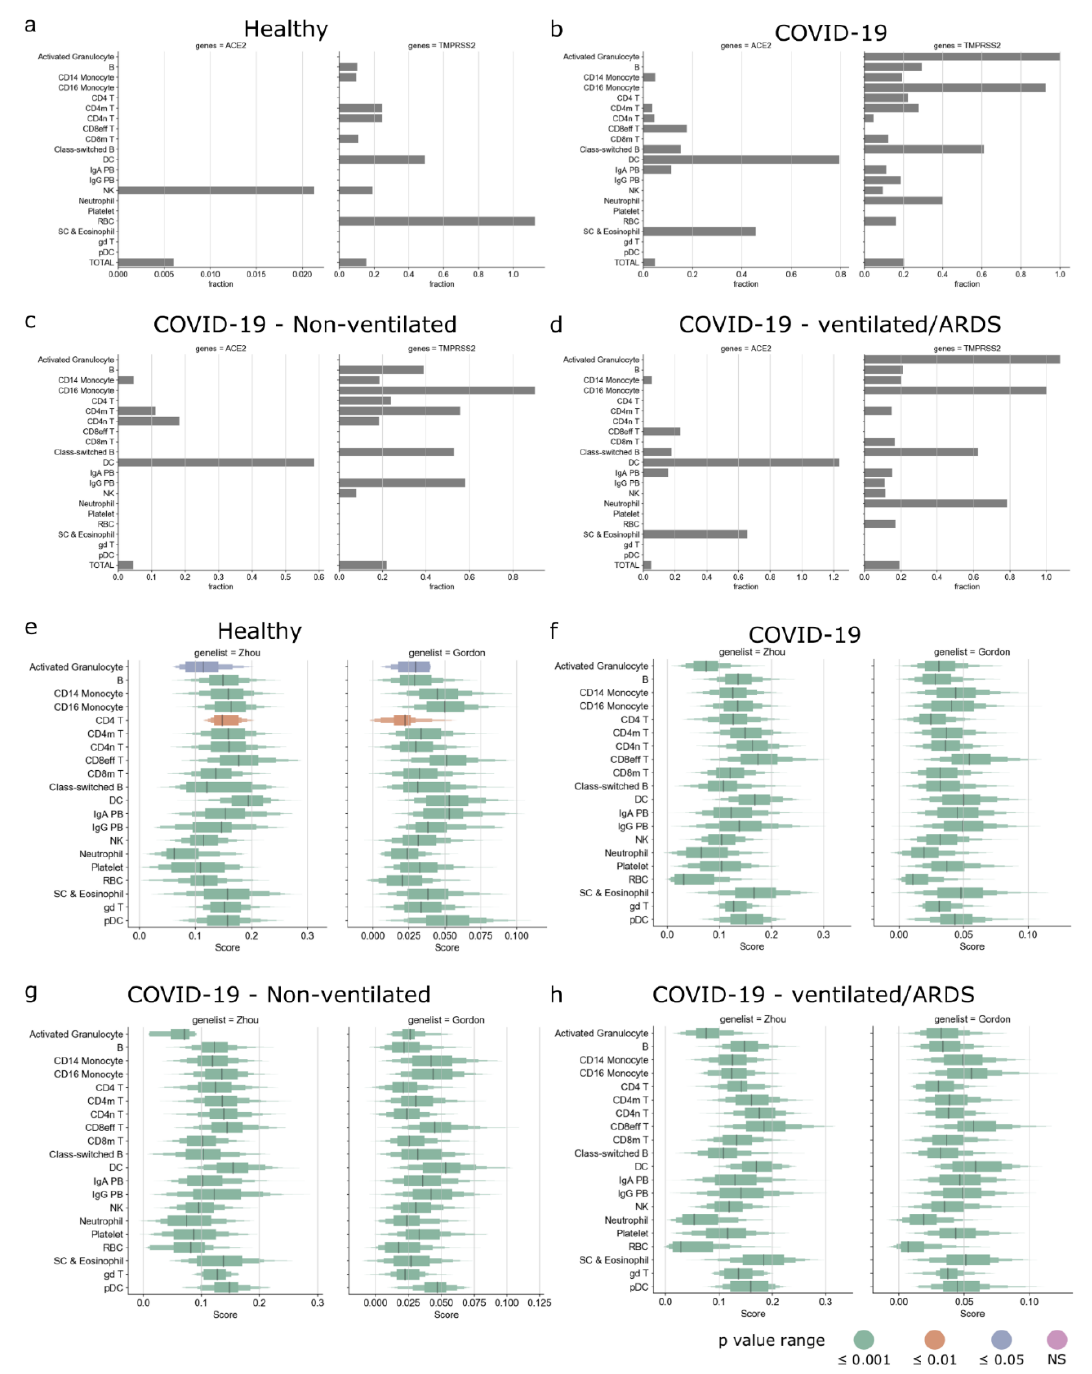
Figure 4. Enrichment of SARS-CoV-2 host factors in PBMCs of COVID-19 patients. Expression of ACE2 and TMPRSS2 in the pooled ( a ) healthy controls, ( b ) all COVID-19 patients, ( c ) non-ventilated COVID-19 patients, and ( d ) COVID-19 patients that developed ARDS. Boxplot showing distribution of gene score of Zhou and Gordon genes for ( e ) healthy controls, ( f ) all COVID-19 patients, ( g ) non-ventilated COVID-19 patients, and ( h ) COVID-19 patients that developed ARDS and were on ventilator.